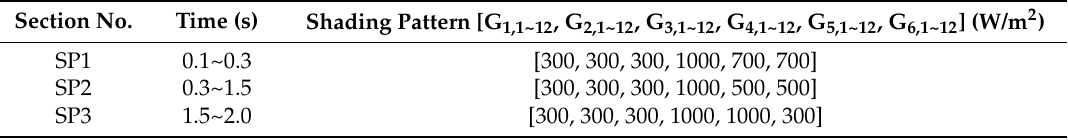
Table 2. Considered shading conditions.